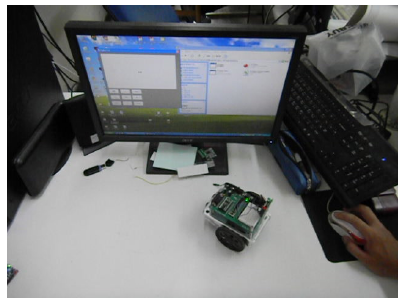
Figure 17. Surrounding environment of the first test.